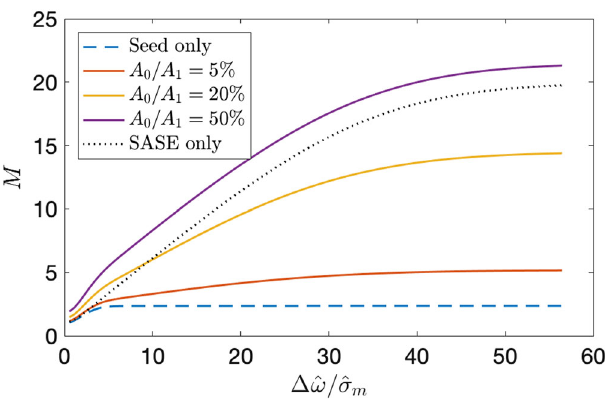
FIG. 4. Total modes versus window bandwidth for varying SASE pedestal amplitude. ˆ σ m ¼ 2